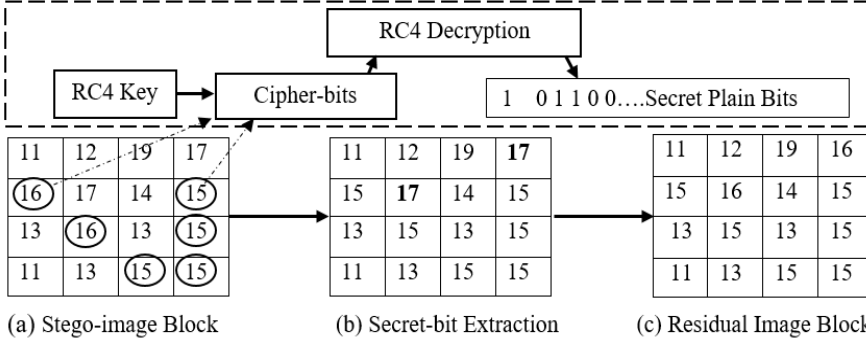
Figure 7. Illustration of Extraction Procedure . Algorithm 2: Pseudocode Extraction Algorithm of the Proposed Scheme